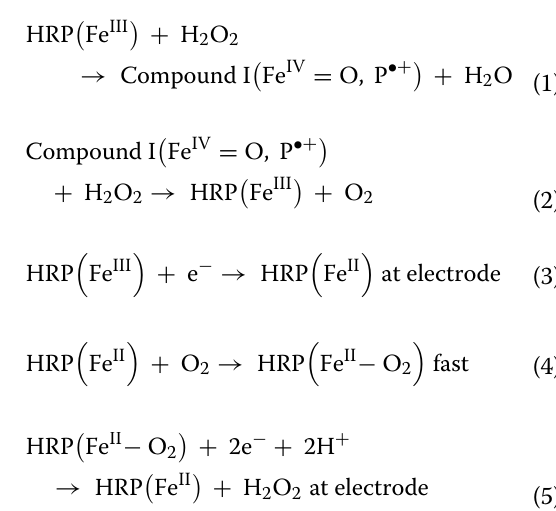
Fig. 4 Cyclic voltammetric responses of: a Bare Au electrode, HRP/ rGO/Au electrode, and HEPNP/rGO/Au electrode in the presence of 100 μM H 2 O 2 , b HEPNP/rGO/Au electrode as a function of H 2 O 2 concentration, and c Linear plot of the reduction current peak at the HEPNP/rGO/Au electrode as a function of H 2 O 2 concentration (n